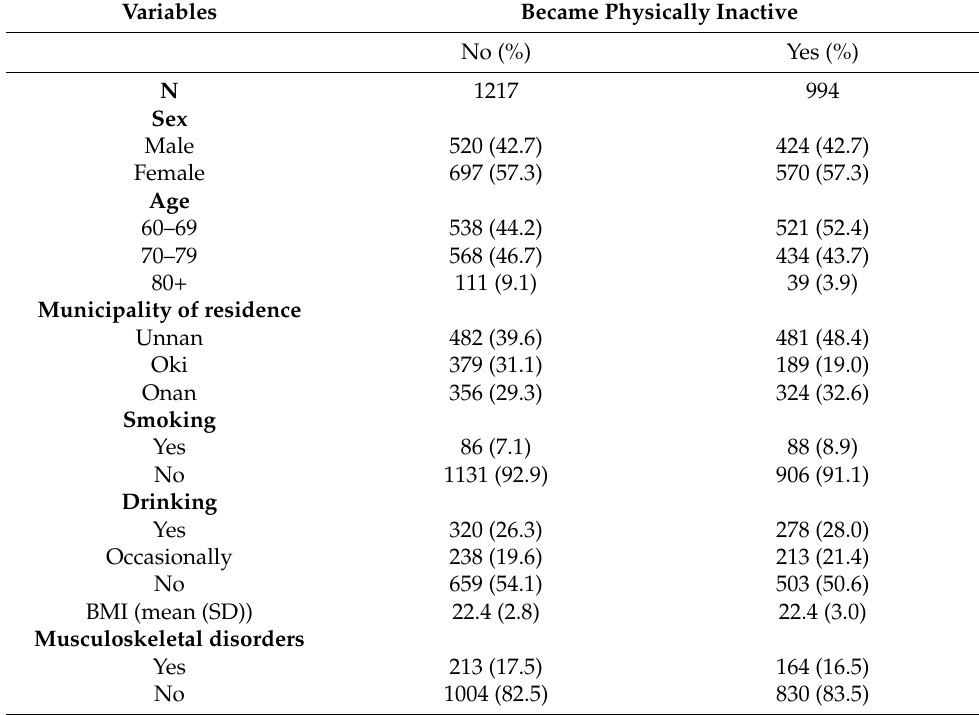
Table 2. Baseline characteristics of study